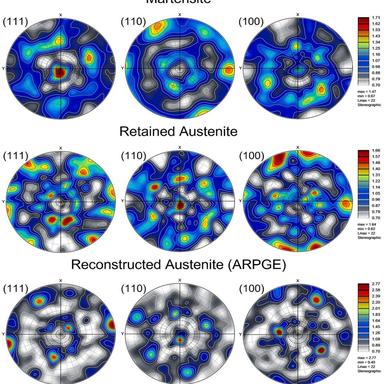
Pole figures for martensite, retained austenite and reconstructed austenite (using ARPGE). The building direction (BD) is parallel to the z axis (the center of the pole figure) and the scanning direction (SD) is spread in the xy plane.